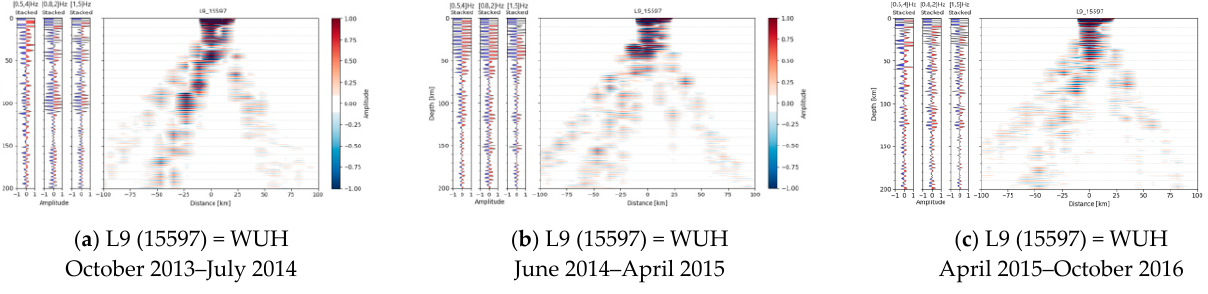
Figure 18. Variation characteristics of underground structure of 15597 (WUH) in different time pe- riods.